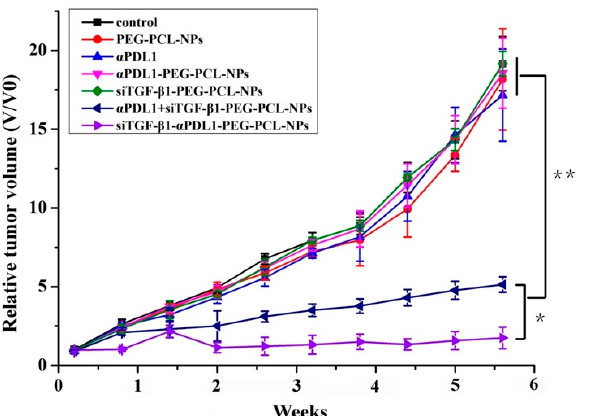
Figure 4. Antitumor efficacies of siTGF- β 1- α PDL1-PEG-PCL-NPs for different treatments upon relative tumor volumes in TGF- β 1 + MFC cell-engrafted mice (* p < 0.05, ** p < 0.01).